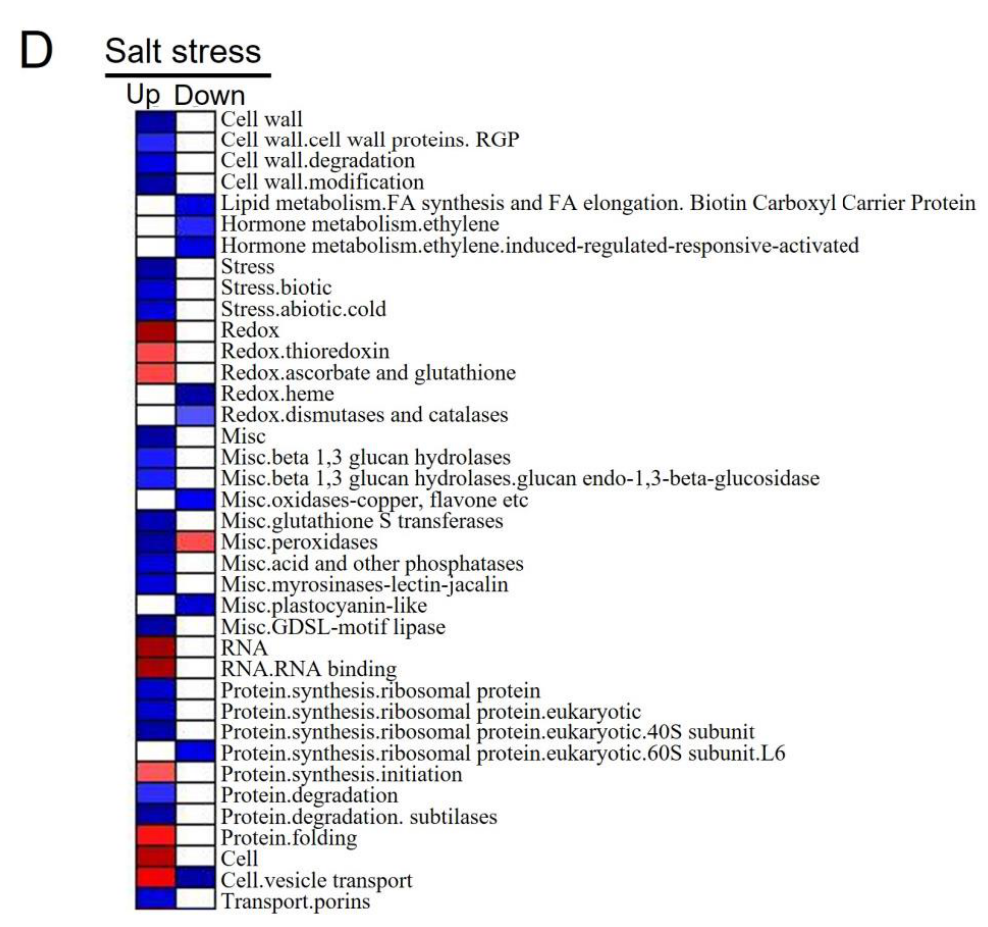
Figure 2. Venn diagrams and pathway enrichment of the differentially expressed proteins in com- parison of NA and NN plants under normal growth conditions (control) and salt stress conditions. ( A ): the total 519 upregulated proteins; ( B ): the total 406 downregulated proteins; ( C ): the pathway changes when comparing NA and NN roots under control conditions with MapMan analysis; ( D ): the pathway changes when comparing NA and NN roots under salt stress conditions with MapMan analysis. Functional categories enrichment was made with Fisher’s exact red color: pathways were significantly under-represented; blue color: pathways are significantly over-represented. NA: alfalfa plants with active nodules; NN: alfalfa plants without nodules.